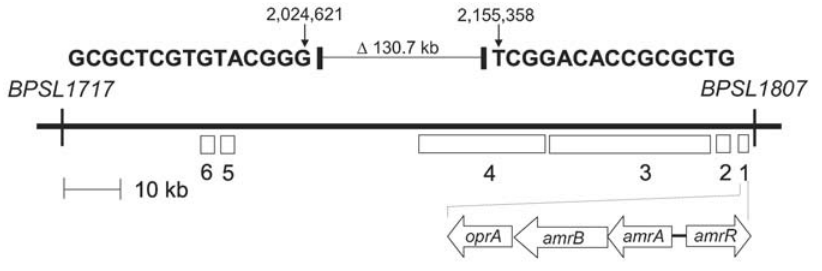
Figure 2. Extent of chromosome 1 deletion in strain 708a compared to K96243. 708a contains a deletion fusing the bold sequences of BPSL1717 and BPSL1807 , respectively. Some notable genes and gene clusters present in K96243 but missing from 708a are: 1 amrR-amrAB-oprA ; 2 a three gene operon ( BPSL1801-BPSL1800-BPSL1799 ) encoding a putative type-1 fimbrial protein along with its outer membrane usher protein and chaperone; 3 the 13 gene malleobactin biosynthetic gene cluster and its extracytoplasmic sigma factor MbaS defined by mbaF-fmtA-mbaA-mbaI- mbaJ-mbaE - BPSL1781-BPSL1782-BPSL1783-BPSL1784-BPSL1785-BPSL1786-mbaS ; 4 a cluster of 18 genes ( BPSL1755 - BPSL1773 ) encoding a putative aerobic (or late cobalt insertion) vitamin B 12 biosynthetic pathway with an embedded gene ( BPSL1763 ) encoding a putative exported chitinase; 5 arcD (BPSL1742) and arcABC ( BPSL1743 - BPSL1744 - BPSL1745 ) coding for the arginine deiminase pathway; and 6 a two gene cluster ( BPSL1732 - BPSL1731 ) coding for a putative methyl-accepting chemotaxis citrate transducer and chemotaxis protein CheW2, respectively. Strain 1710b contains an additional 10 kb of DNA in this region.